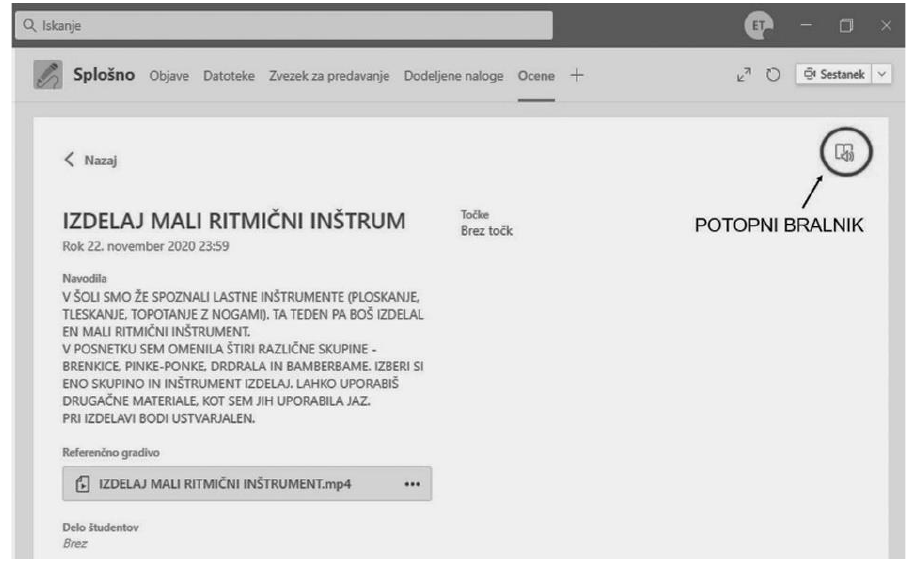
Figure 3. Use of Microsoft Teams e-classroom in the planning of a remote cross-curricular assignment including music and visual art.